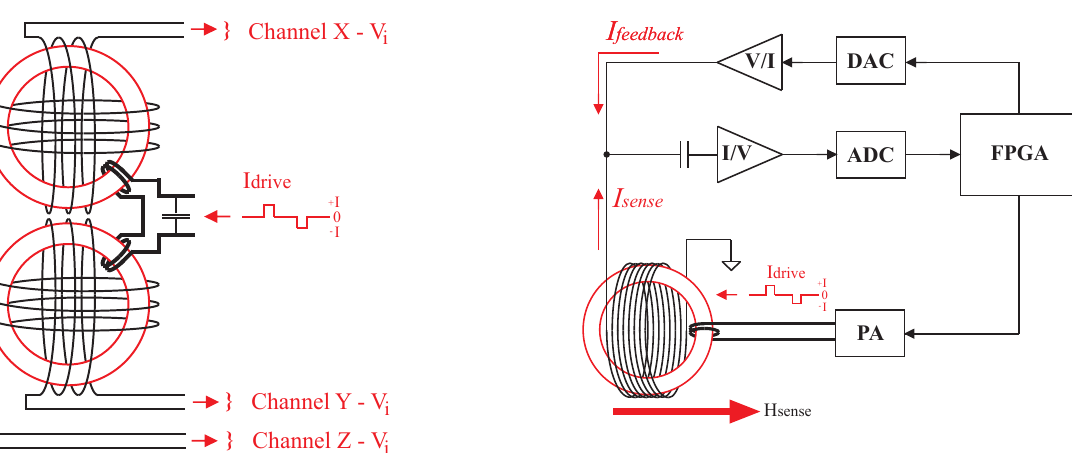
Fig. 2. Schematic wiring of the X , Y , and Z sensor components and the drive winding in the prototype. X and Y are single windings while Z is derived from two windings in series. Note that the two ring cores are physically orthogonal as shown in Fig. 1.